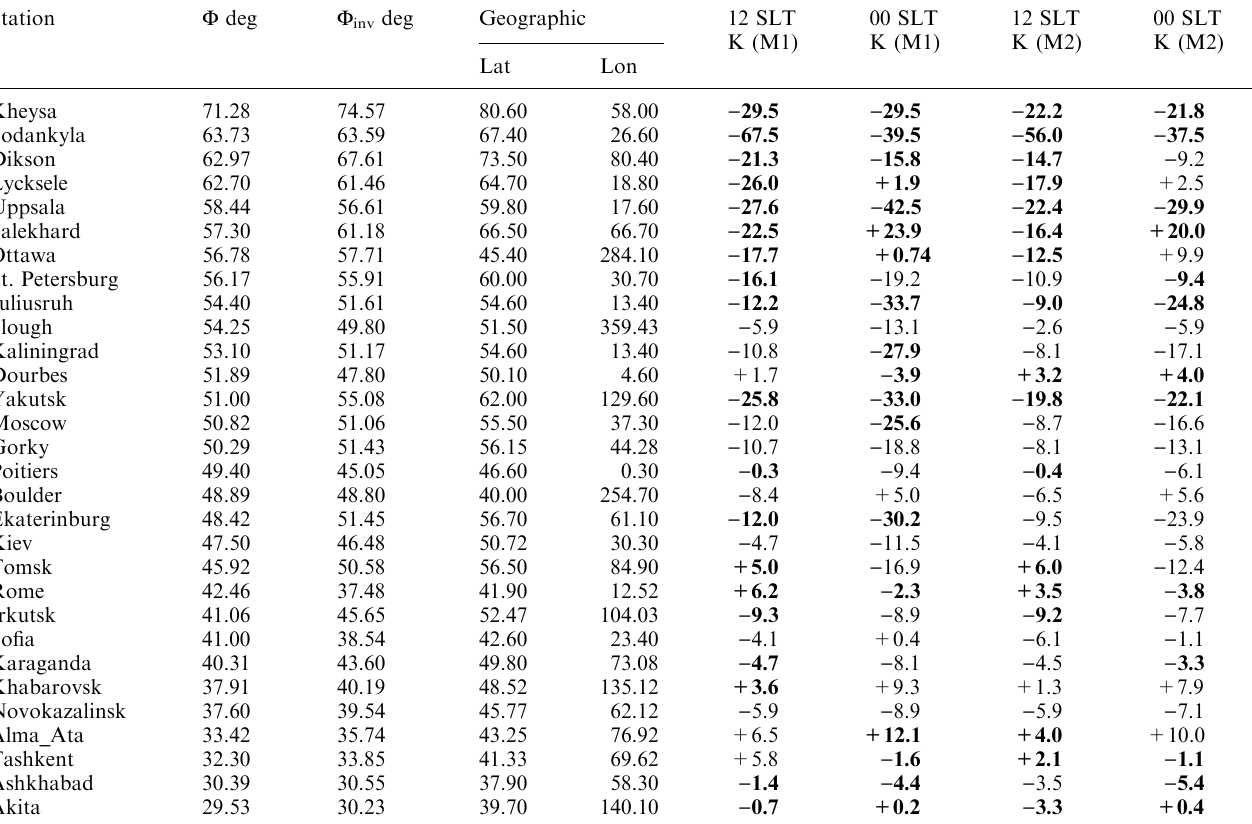
Table 2. Ionosonde stations and calculated annual mean slope K (in 10 ) 4 per year) for the period after 1965. Regressions f oF2 with R (model 1) and with R + Ap (model 2) are used to make f oF2 12 12